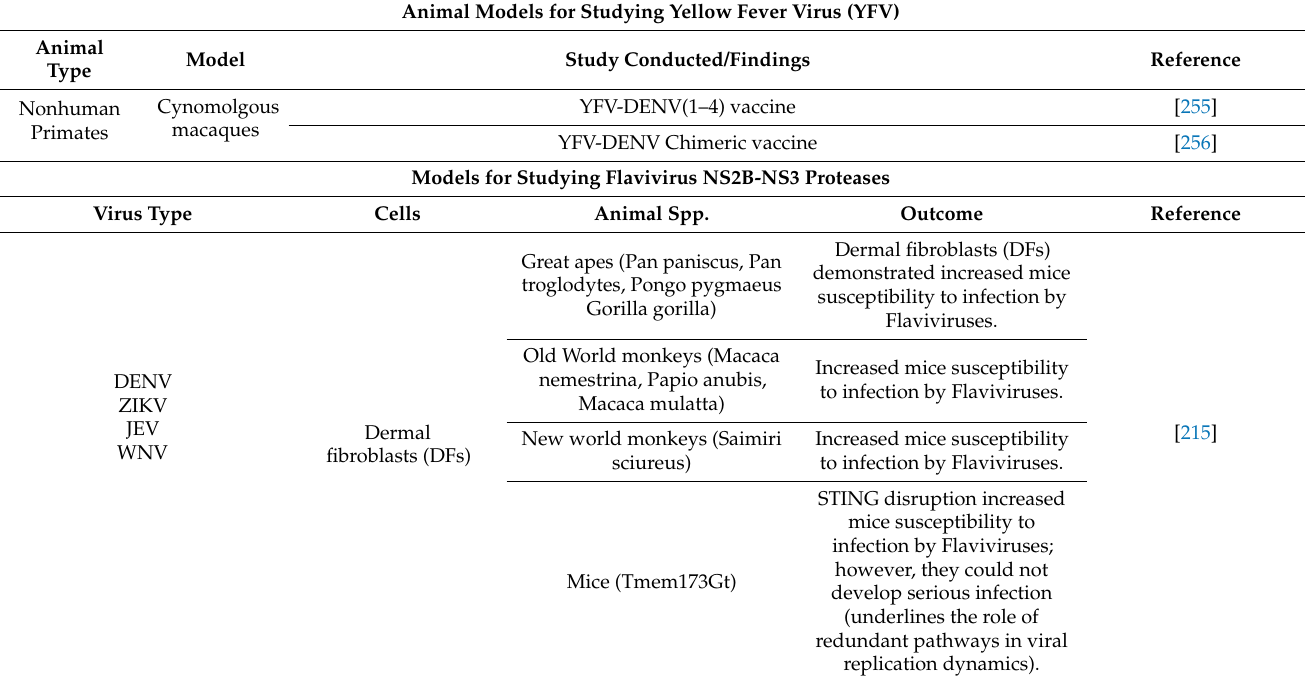
Table 4. Cont . Animal Models for Studying Yellow Fever Virus